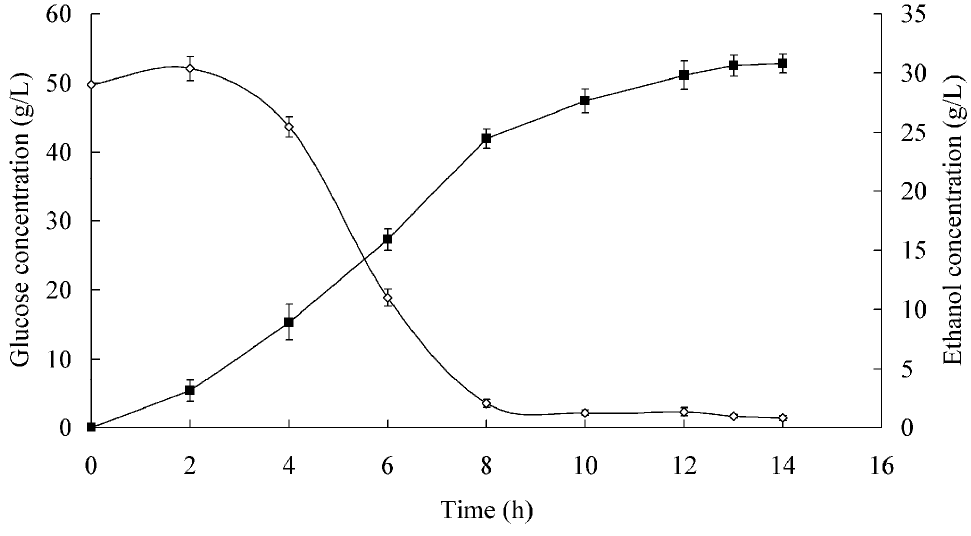
Figure 5. Time course of ethanol fermentation of L. punctata mash pretreated by pectinase under optimal conditions. ( ■ ): Ethanol concentration (g/L); ( ◇ ): Glucose concentration (g/L). Error bars represent standard